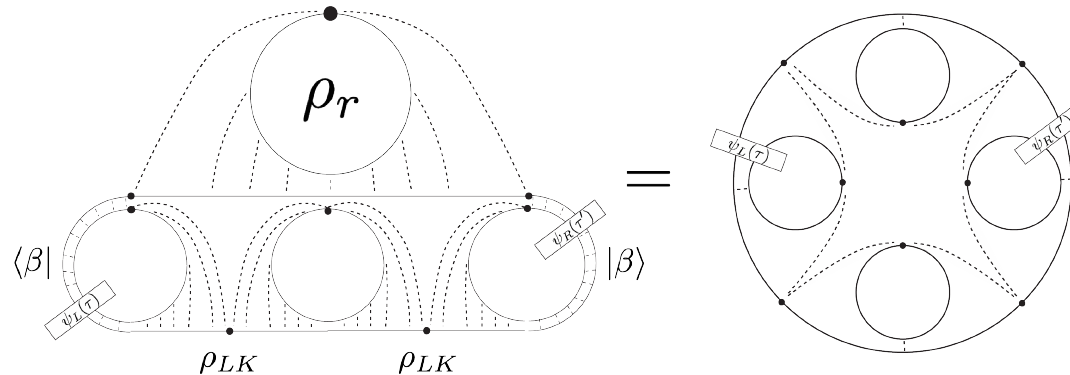
⊗ ρ r ) ψ R ( τ 0 ) | β i . Since only the LK